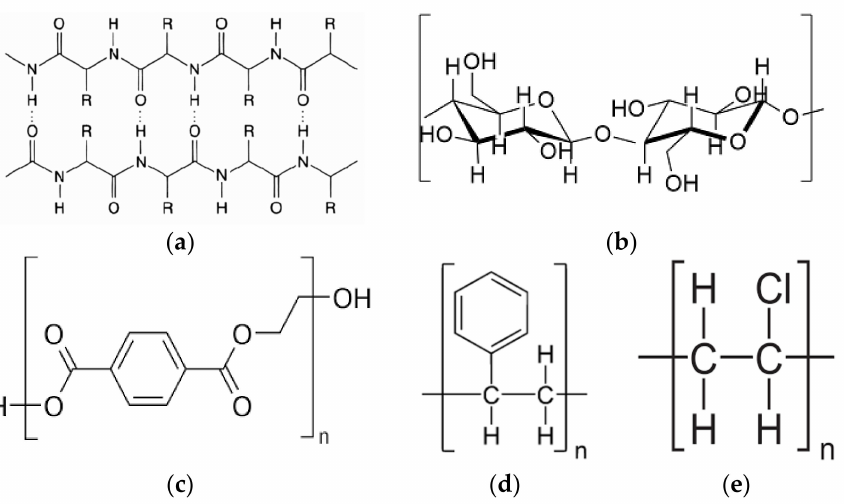
Figure 2. Chemical structure of ( a ) beta-keratin, ( b ) cellulose, ( c ) polyethylene terephthalate, ( d ) polystyrene, and ( e ) polyvinyl